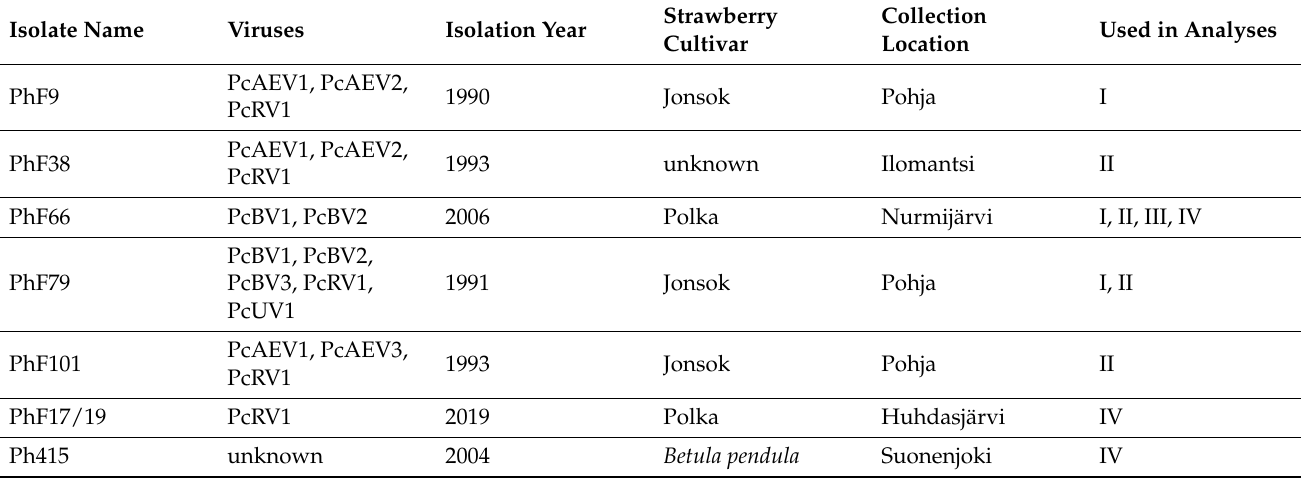
Table 1. Phytophthora cactorum isolates used in this study. The viruses infecting these isolates are also given. PcAEV1–3 = Phytophthora cactorum alphaendornavirus 1–3; PcBV1–3 = Phytophthora cactorum bunya-like viruses 1–3; PcRV1 = Phytophthora cactorum RNA virus 1 (putative Totiviridae ;